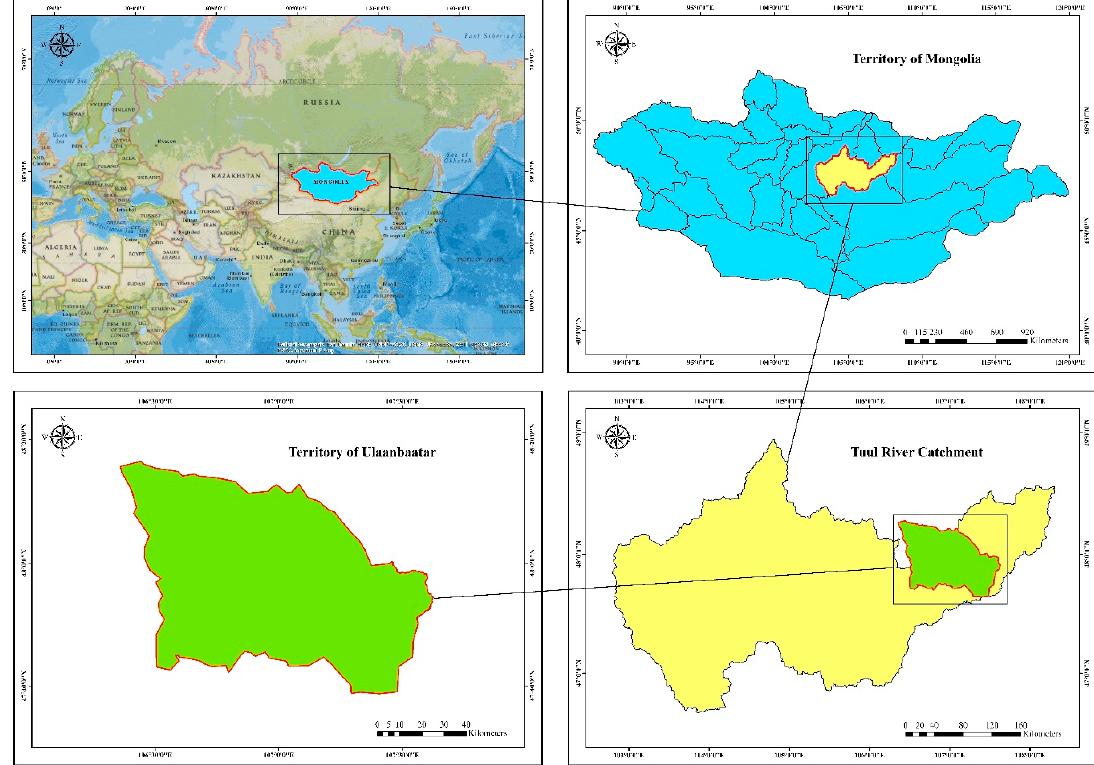
Figure 1. Study area of Ulaanbaatar city, which is the capital of Mongolia.